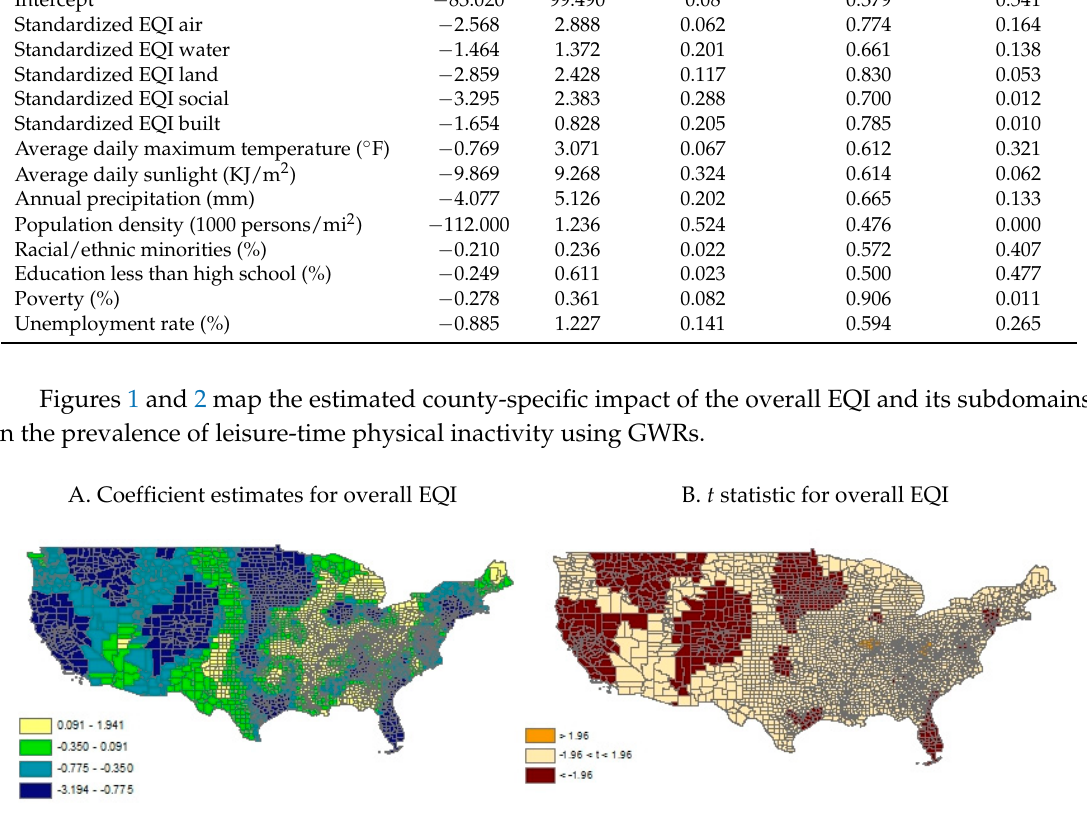
Figure 1. Estimated county-specific impacts of standardized overall EQI on physical inactivity prevalence using GWR.